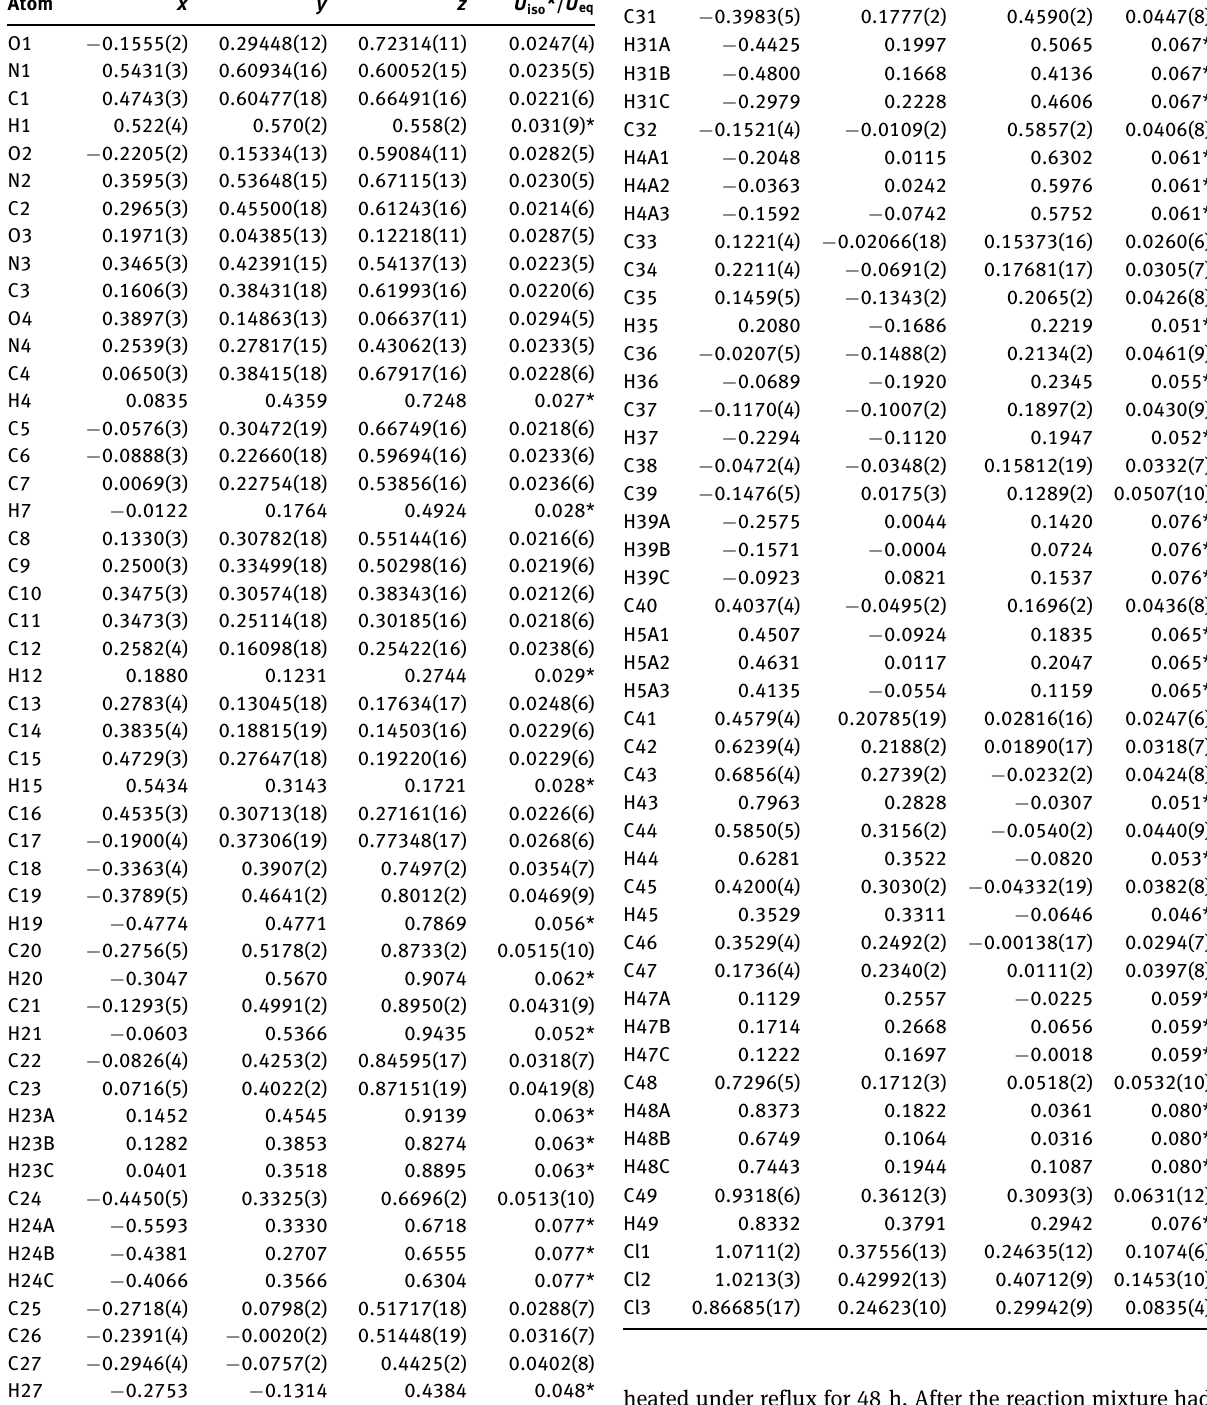
Table 2: Fractional atomic coordinates and isotropic or equivalent isotropic displacement parameters (Å 2